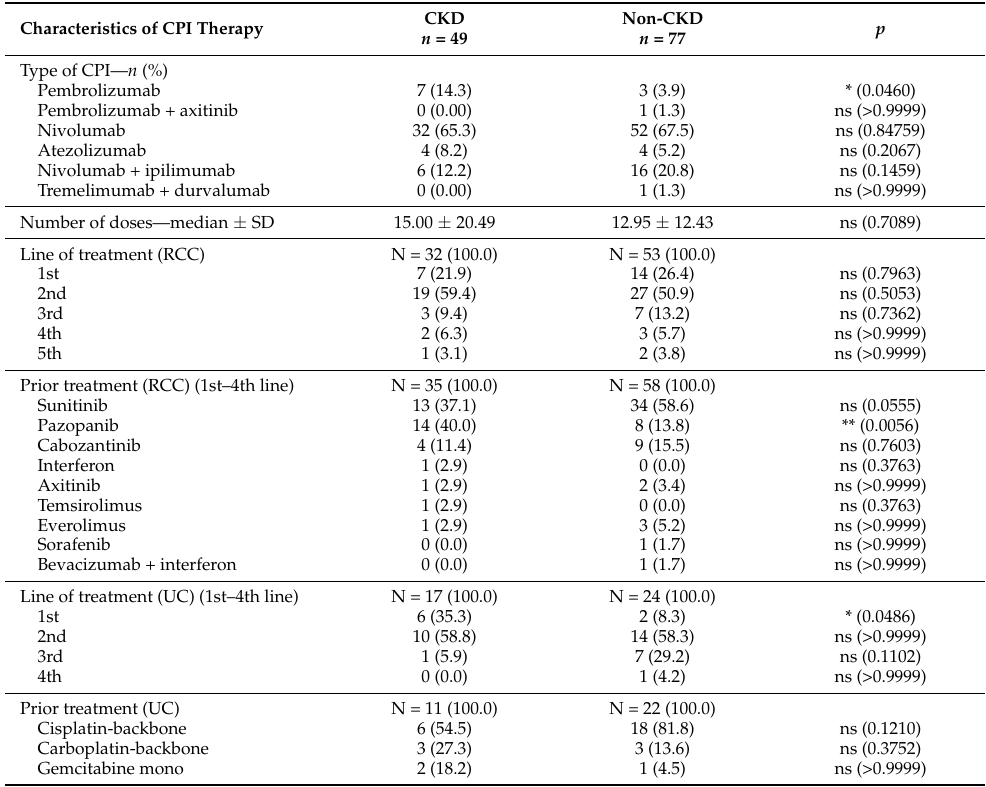
Table 3. Characteristics of checkpoint inhibitor therapy. CKD = chronic kidney disease; CPI = Checkpoint inhibitor; RCC = renal cell carcinoma; UC = urothelial carcinoma; ns = not significant; * = significant; ** = very